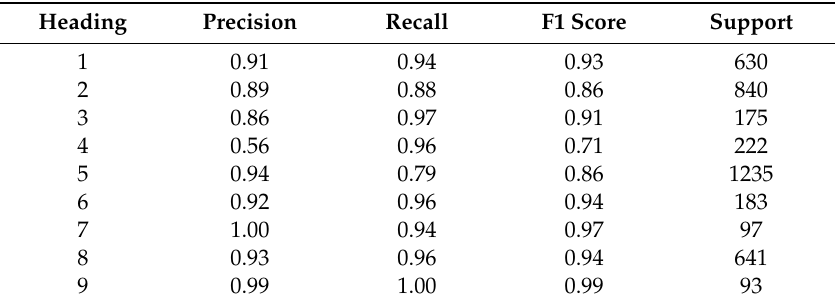
Table 2. The results of the cross-validation training